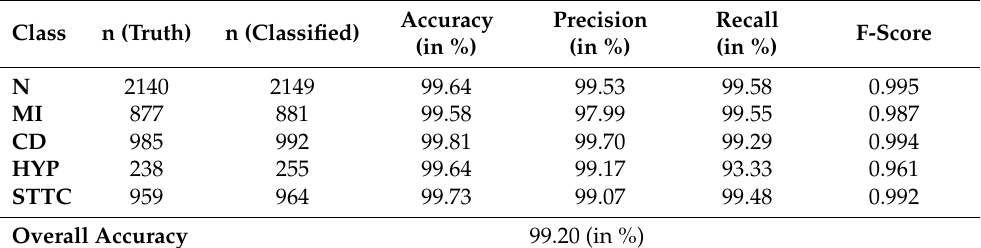
Table 7. Overall performance of the proposed CNN model with the SVM for each